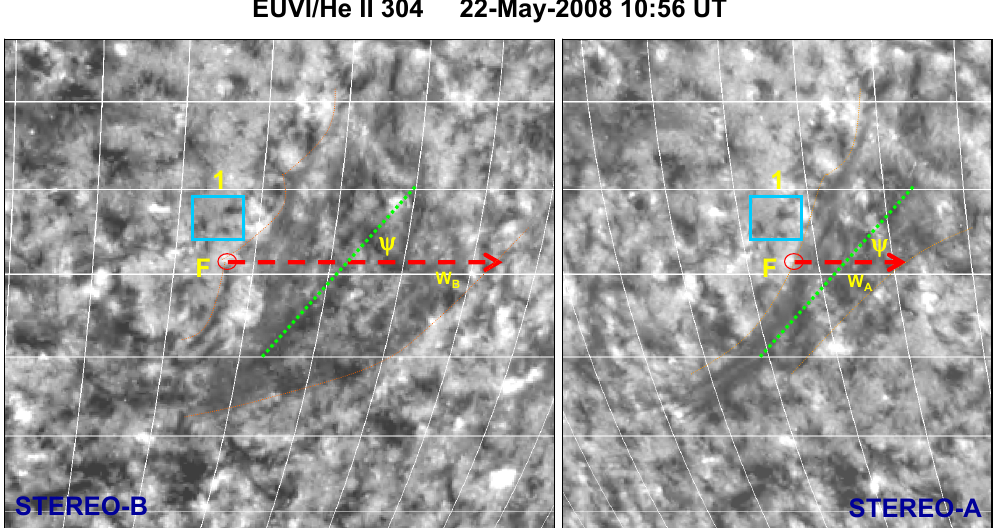
Fig. 2. The He II 304 ˚A observations of a filament on 22 May 2008 during its disappearance phase at 10:56UT. The separation angle of about 52.4 degrees between STEREO satellites shows quite different view of the filament. The spherical grid overlaid on the images help to distinguish between surface and elevated features. The location “F” is identified as the feet of the filament. The projected width W A and W B is marked by red arrow. Green line marks the orientation ψ of the filament. Thin orange lines are drawn to demarcate the boundary of the filament. The features inside box “1” are surface features which are seen on left-side of the filament in both images, suggesting that the filament inclination is larger than “ A ”.